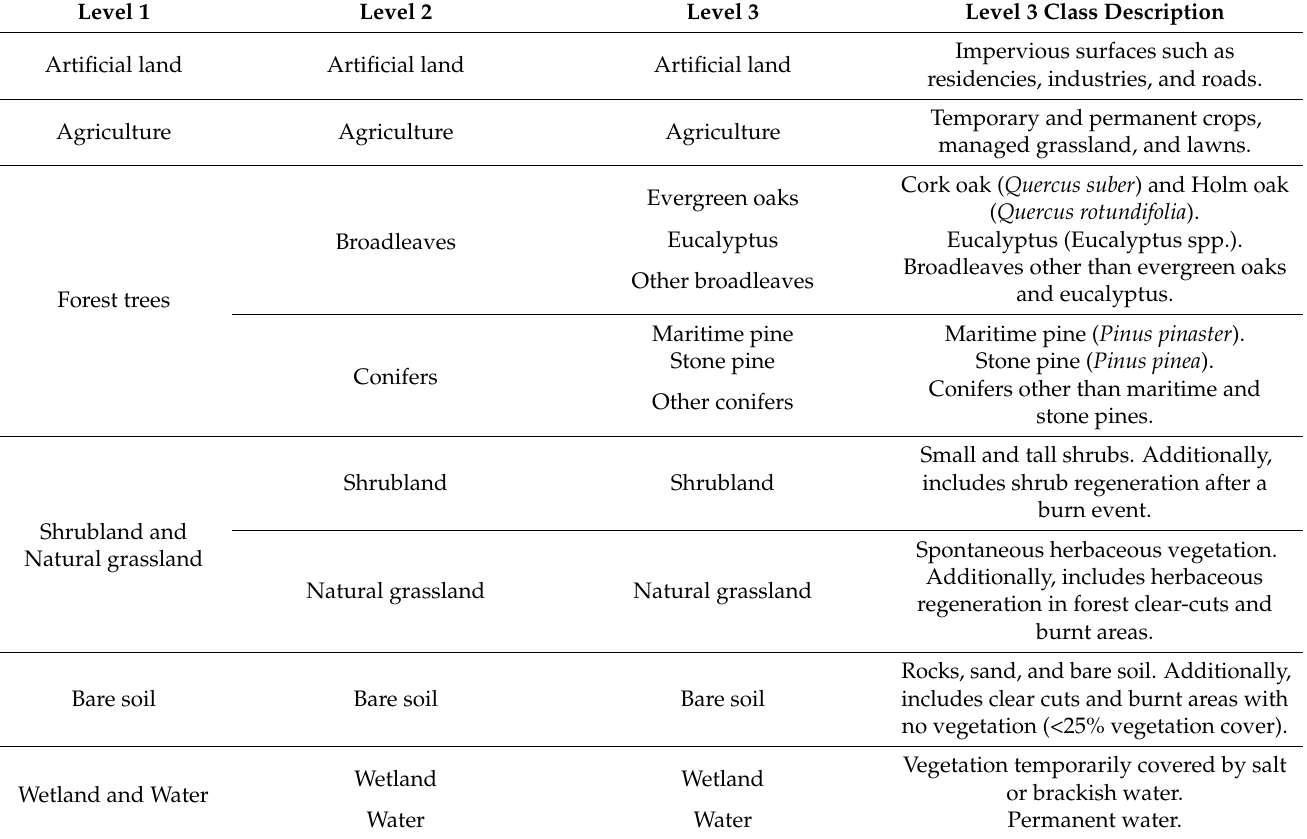
Table 1. Land cover